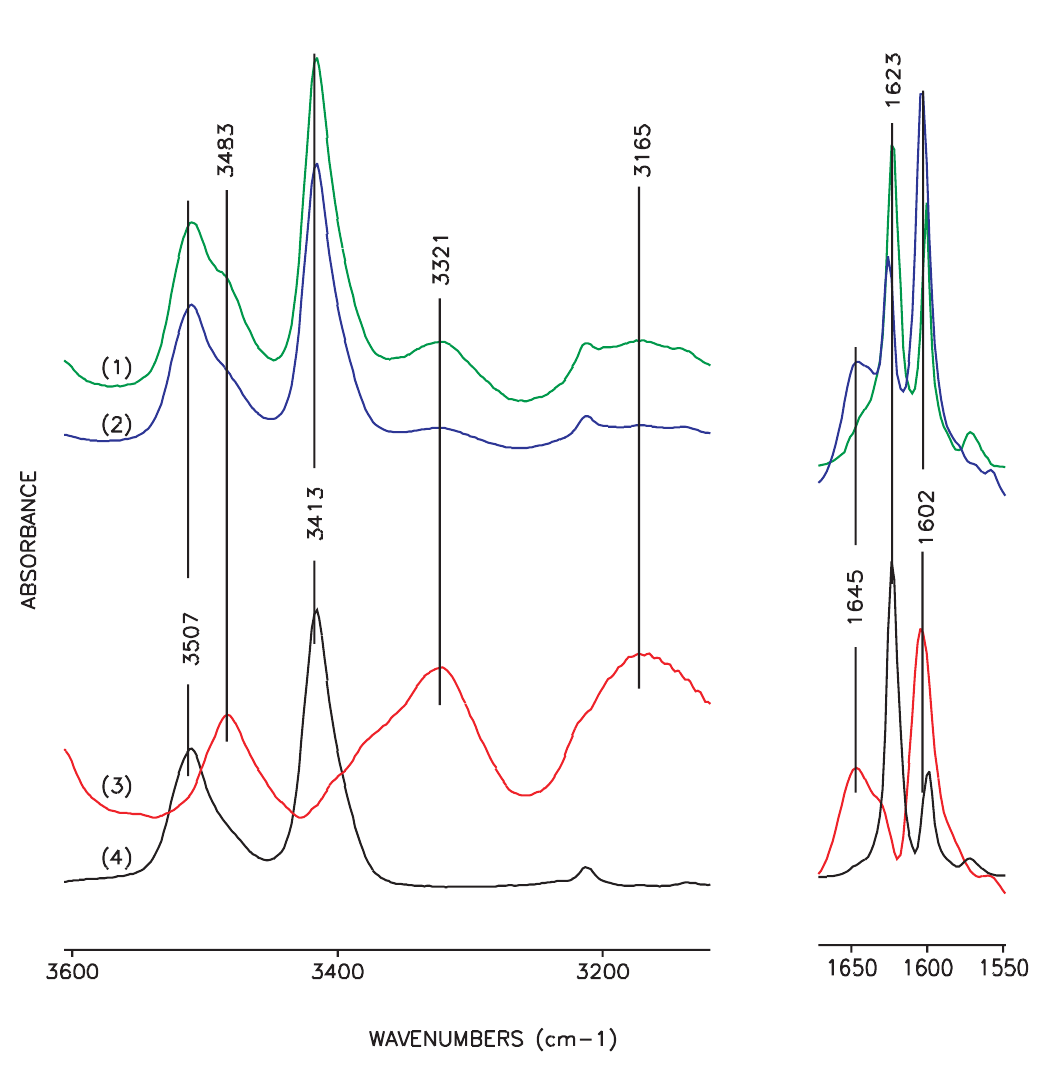
Fig. 2 NH 2 – stretching and scissoring region of 4-AP in chloroform: 1.10 − 1 M (1) and saturated solution (2); Corresponding reduced spectra after elimination of the bands at 3507 cm − 1 (3) and 1645 cm − 1